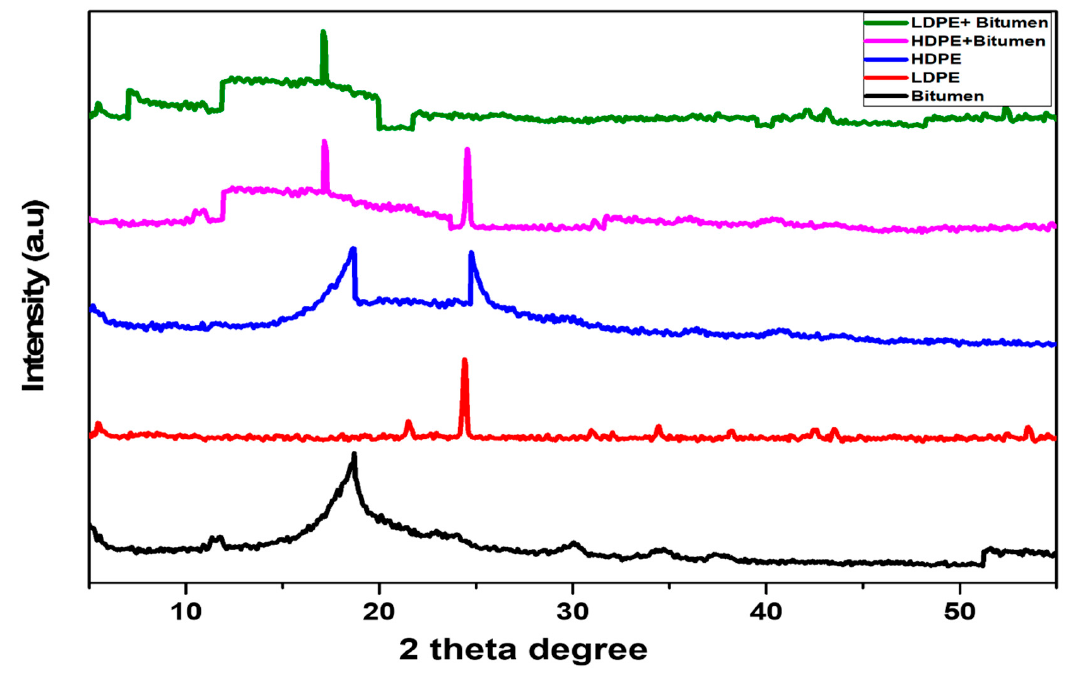
Figure 6. An XRD analysis of neat, HDPE, and LDPE modified bitumen.